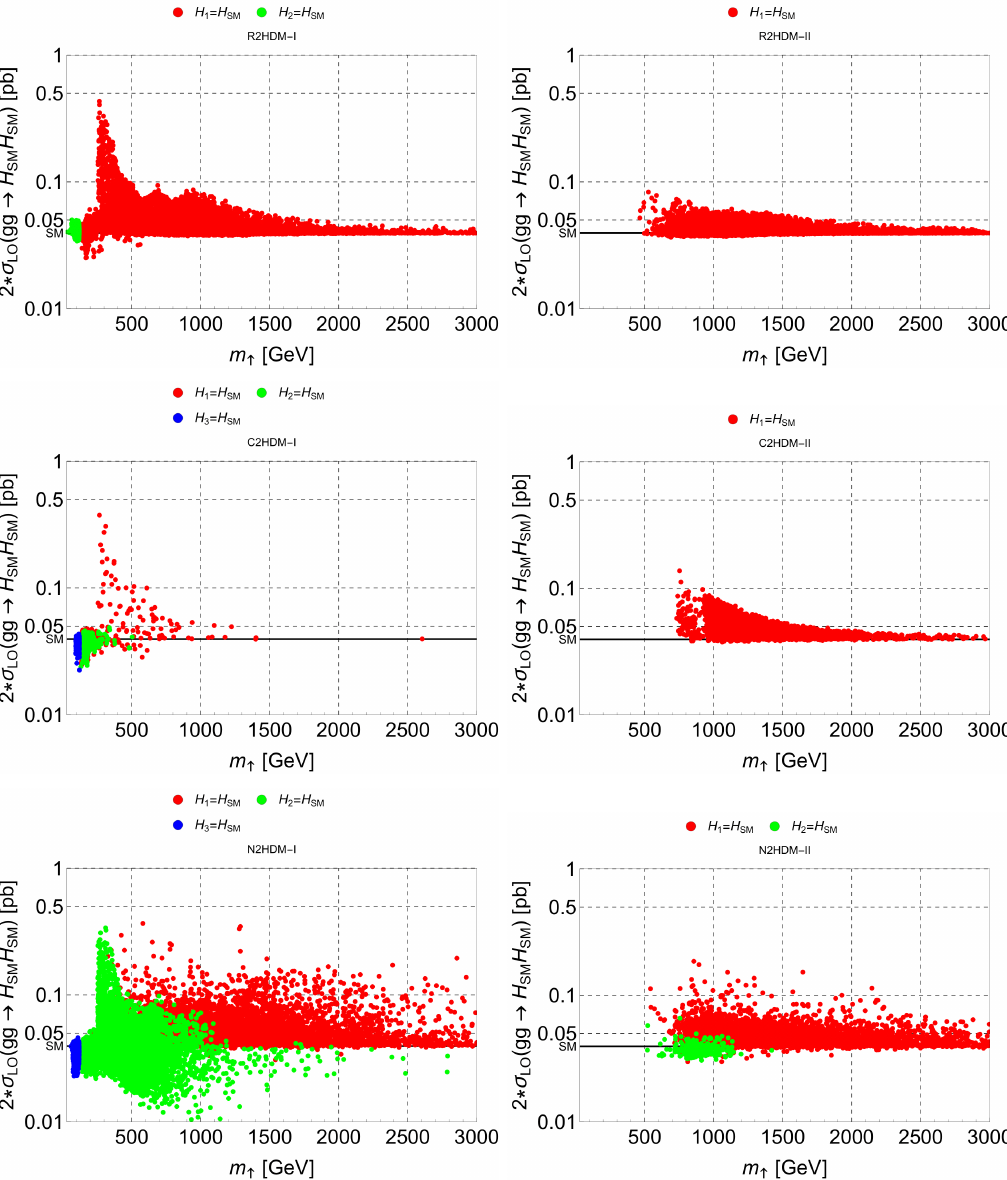
Figure 7 . Scatter plots for SM-like Higgs pair production including a factor of 2 for estimating the NLO QCD corrections, for all points passing the constraints, as a function of the mass of the heavier of the non-SM-like Higgs bosons m for the R2HDM (upper), the C2HDM (middle), and the ↑ N2HDM (lower line), for type 1 (left column) and type 2 (right column). Red points for scenarios with H , green ones for those where H , and blue points for those where H . 1 ≡ H SM 2 ≡ H SM 3 ≡ H SM Horizontal line: SM